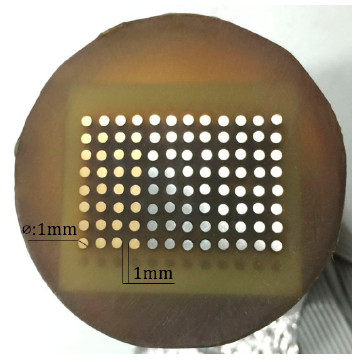
Figure 1. Schematic of a wire-beam electrode.